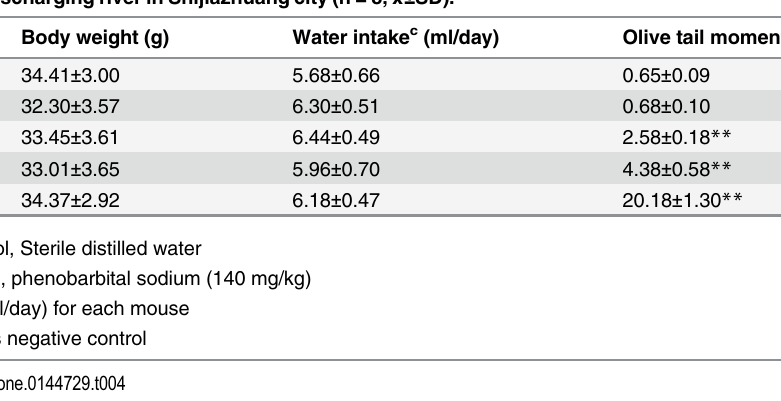
Table 4. Results from SCGE in mouse hepatocytes induced by the irrigative wastewater taken from the Dongming discharging river in Shijiazhuang city (n = 8, x ±